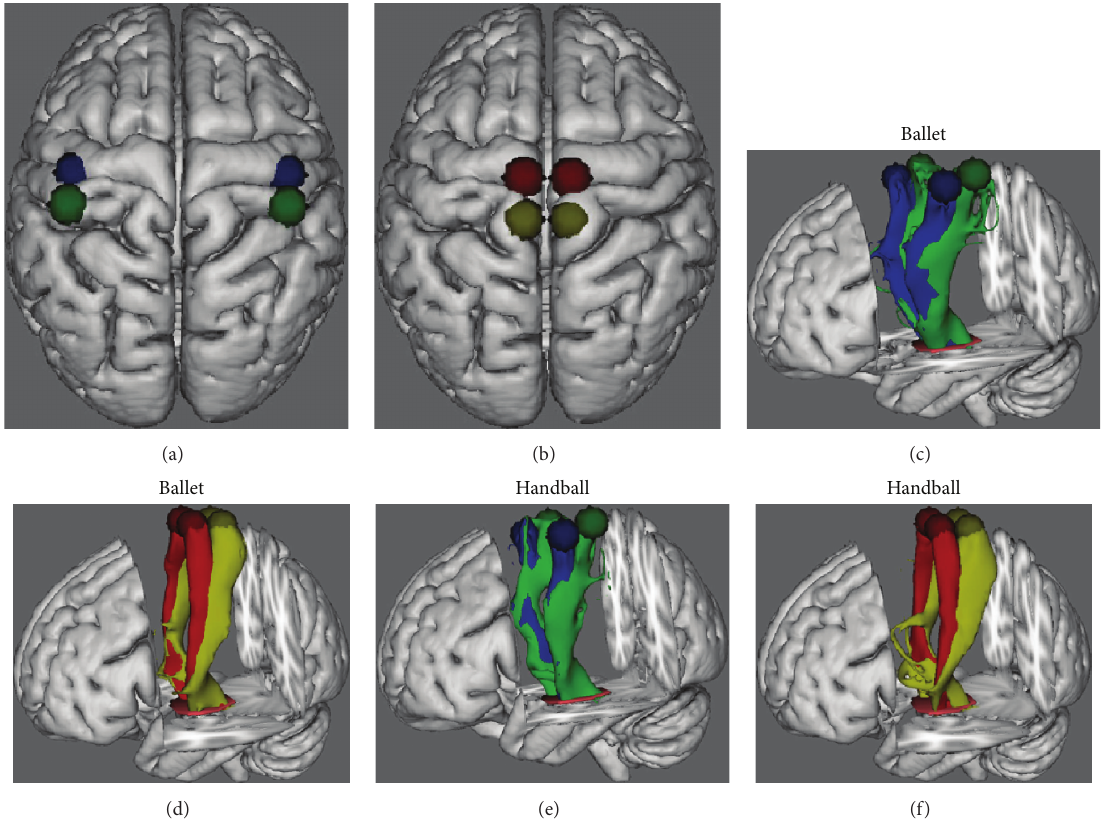
Figure 2: Probabilistic reconstruction of the corticospinal tracts (CSTs). (a) shows both, the spherical masks used for the VBM and the DTI analysis of the predefined hand areas in M1 (blue) and S1 (green) and (b) of the predefined foot areas in M1 (red) and S1 (yellow). (c–f) Probabilistic reconstruction of the WM fibres representing the mean CSTs of all ballet dancers (c and d) and all handball players (e and f), respectively, between the left- and the right-hemispheric hand areas (blue: M1, green: S1) and the left- and the right-hemispheric foot areas (red: M1, yellow: S1) and the brainstem (orange).